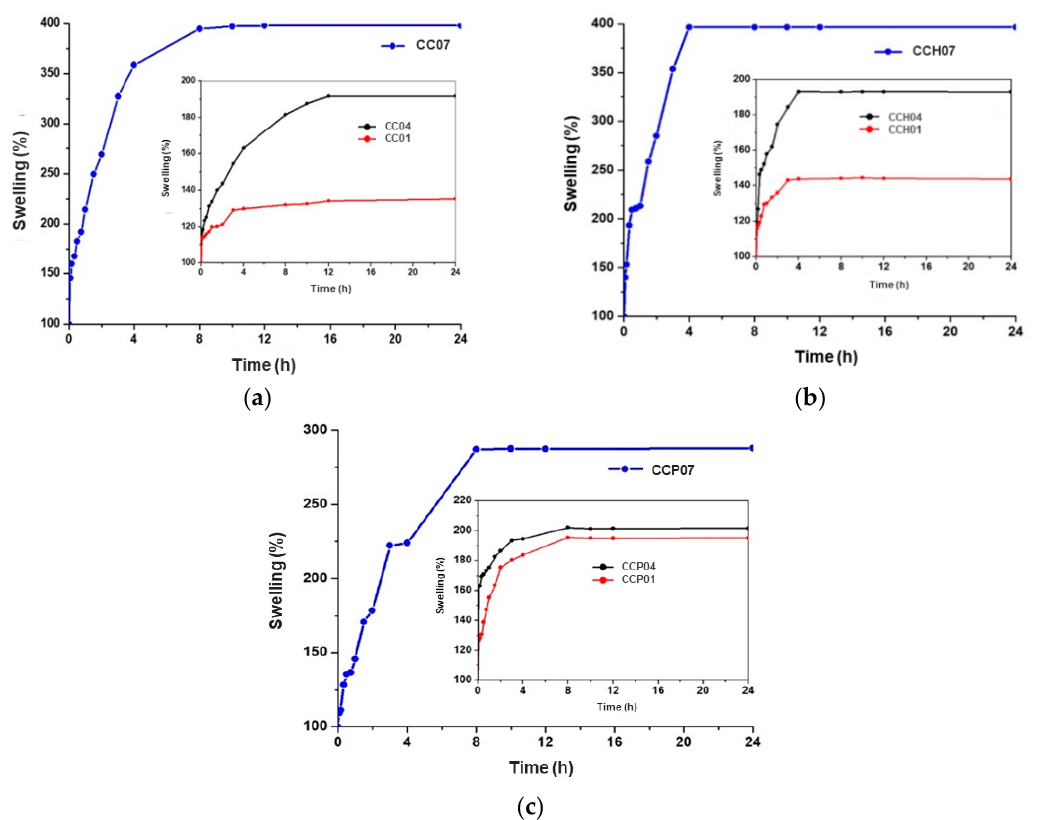
Figure 3. Equilibrium swelling time of different systems: ( a ) CC01, CC04, and CC07; ( b ) CCH01, CCH04, and CCH07 nanocomposites modified with HDTMA; ( c ) CCP01, CCP04, and CCP07 nanocomposites modified with PTMA.